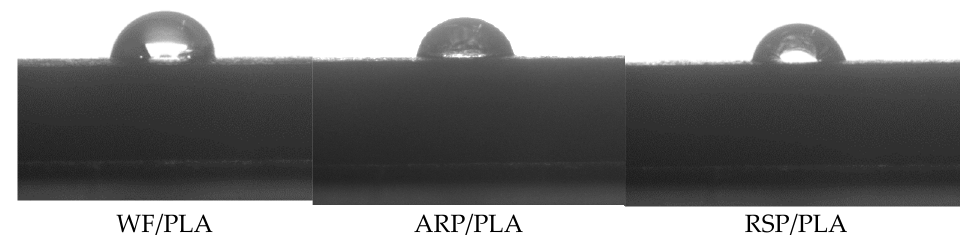
Figure 8. Contact angles of deionized water on surfaces of different samples. Table 3. Contact angles of deionized water on surfaces of different samples.